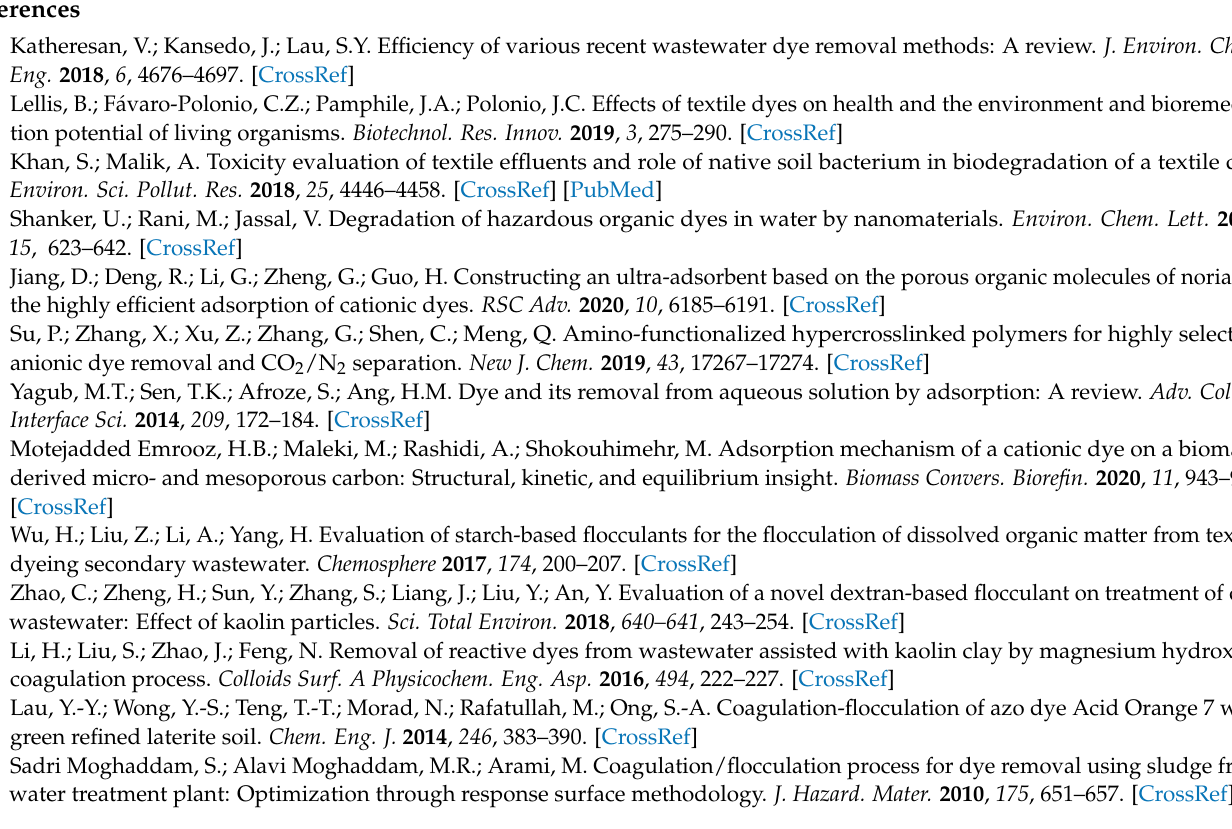
Fe; Figure S3: TGA spectrum of Catechol-HCP-w; Figure S4: TGA spectrum of Catechol-HCP-Fe; Figure S5: Kinetic plots of MB degradation using (a) zero-order, (b) first-order, (c) second-order kinetic model; Figure S6: Degradation efficiency using different initial pH; Figure S7: Degradation efficiency using different reaction temperature; Figure S8: Degradation efficiency of the reused catalyst without Fe reloading; Figure S9: Degradation efficiency of the reused catalyst with Fe reloading; Table S1: EDX elemental analysis (weight%) of